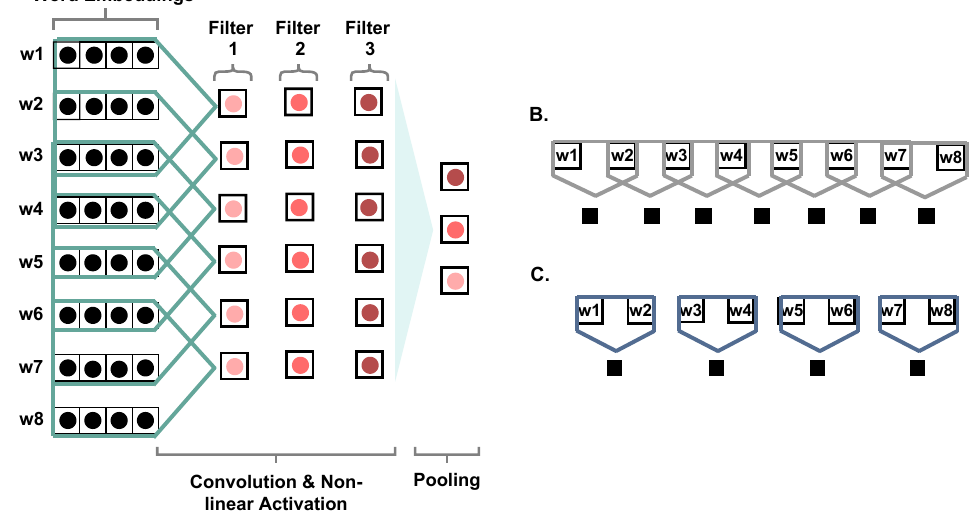
Figure 3. Description of the convolutional neural networks. In ( A ), the filter size is 3 and the stride is 1, ( B ) the filter size is 2 and the stride is 1, and ( C ) the filter size is 2 and the stride is